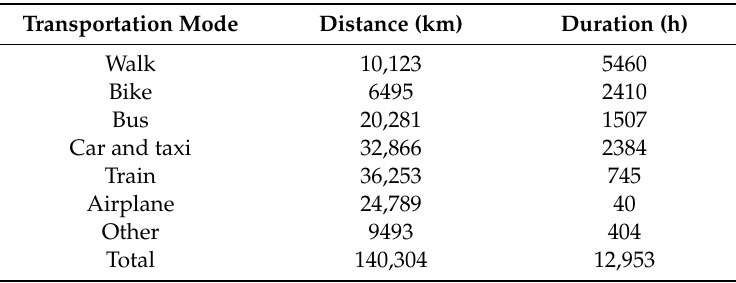
Table 2. Total distance and duration of transportation modes.